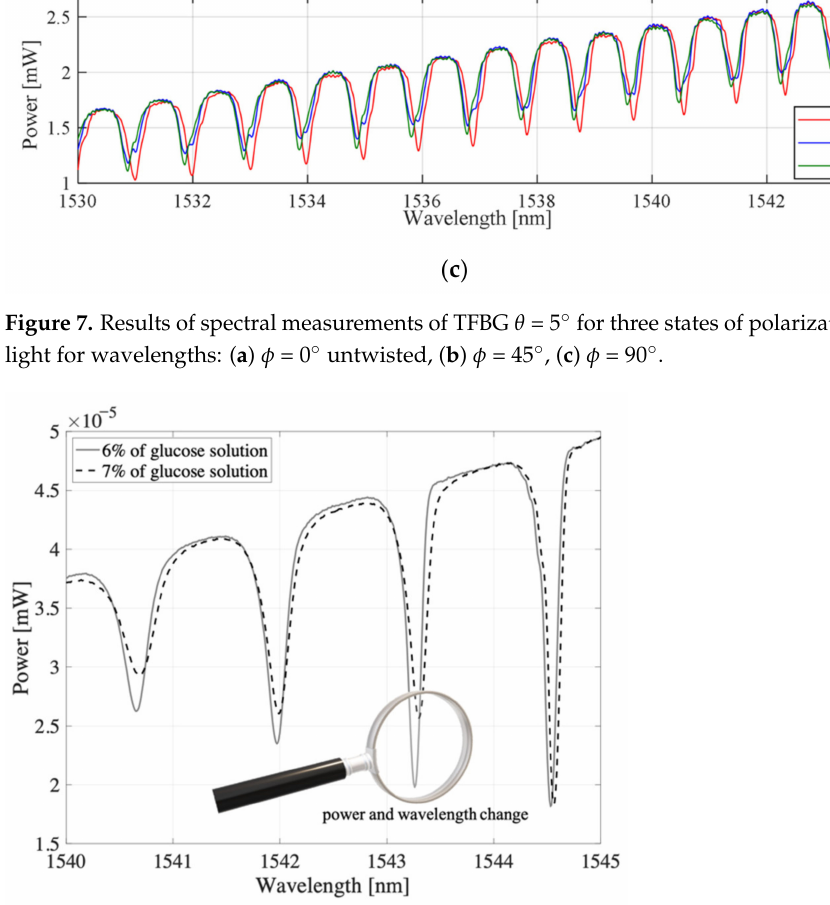
Figure 8. Evolution of spectral characteristics measured in transmission mode induced by a 1% change in glucose concentration (preliminary tests). TFBG: θ = 8 ◦